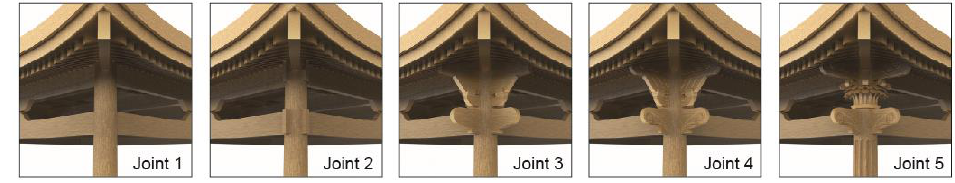
Figure 1. Stimuli were shown to the